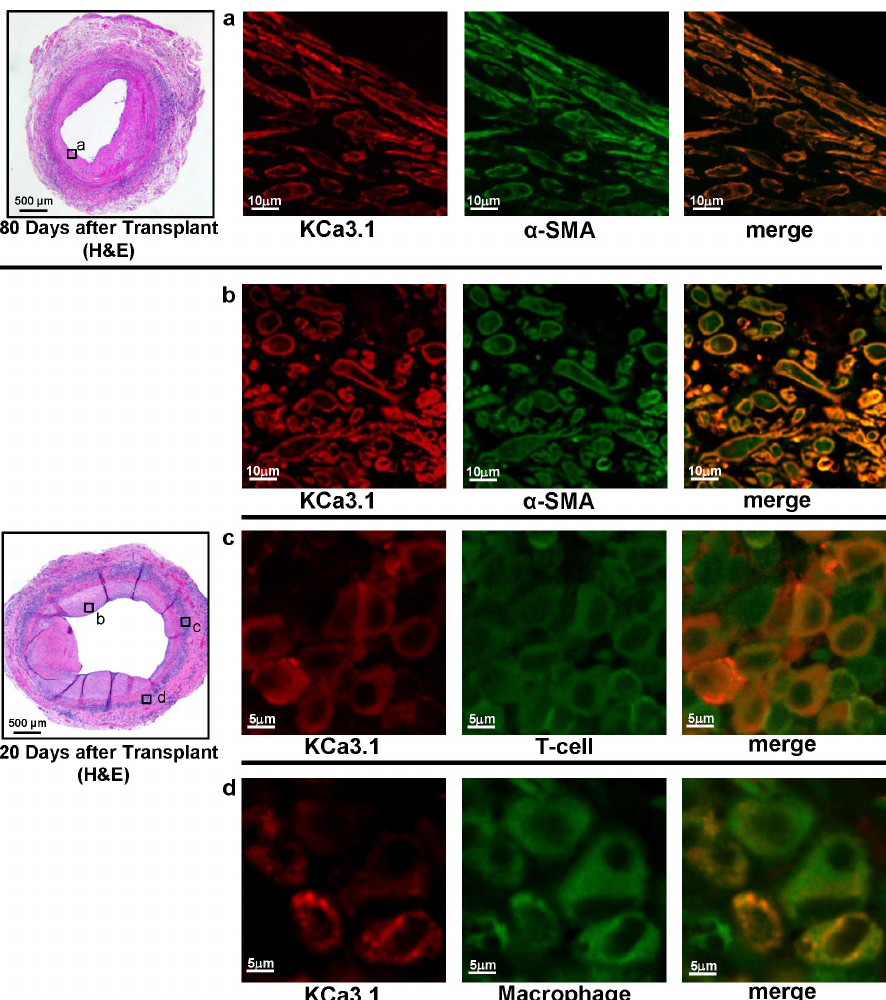
Figure 2. KCa3.1 staining localizes to smooth muscle cells, T cells and macrophages. Double fluorescent immunostaining for KCa3.1 and a -SMA, T cells (CD43) and macrophages (ED1, CD68) in orthotopic rat aorta transplants harvested 80 or 120 days after transplantation. The boxed areas in the H&E stained vessels on the right show the location where the fluorescent images were taken.